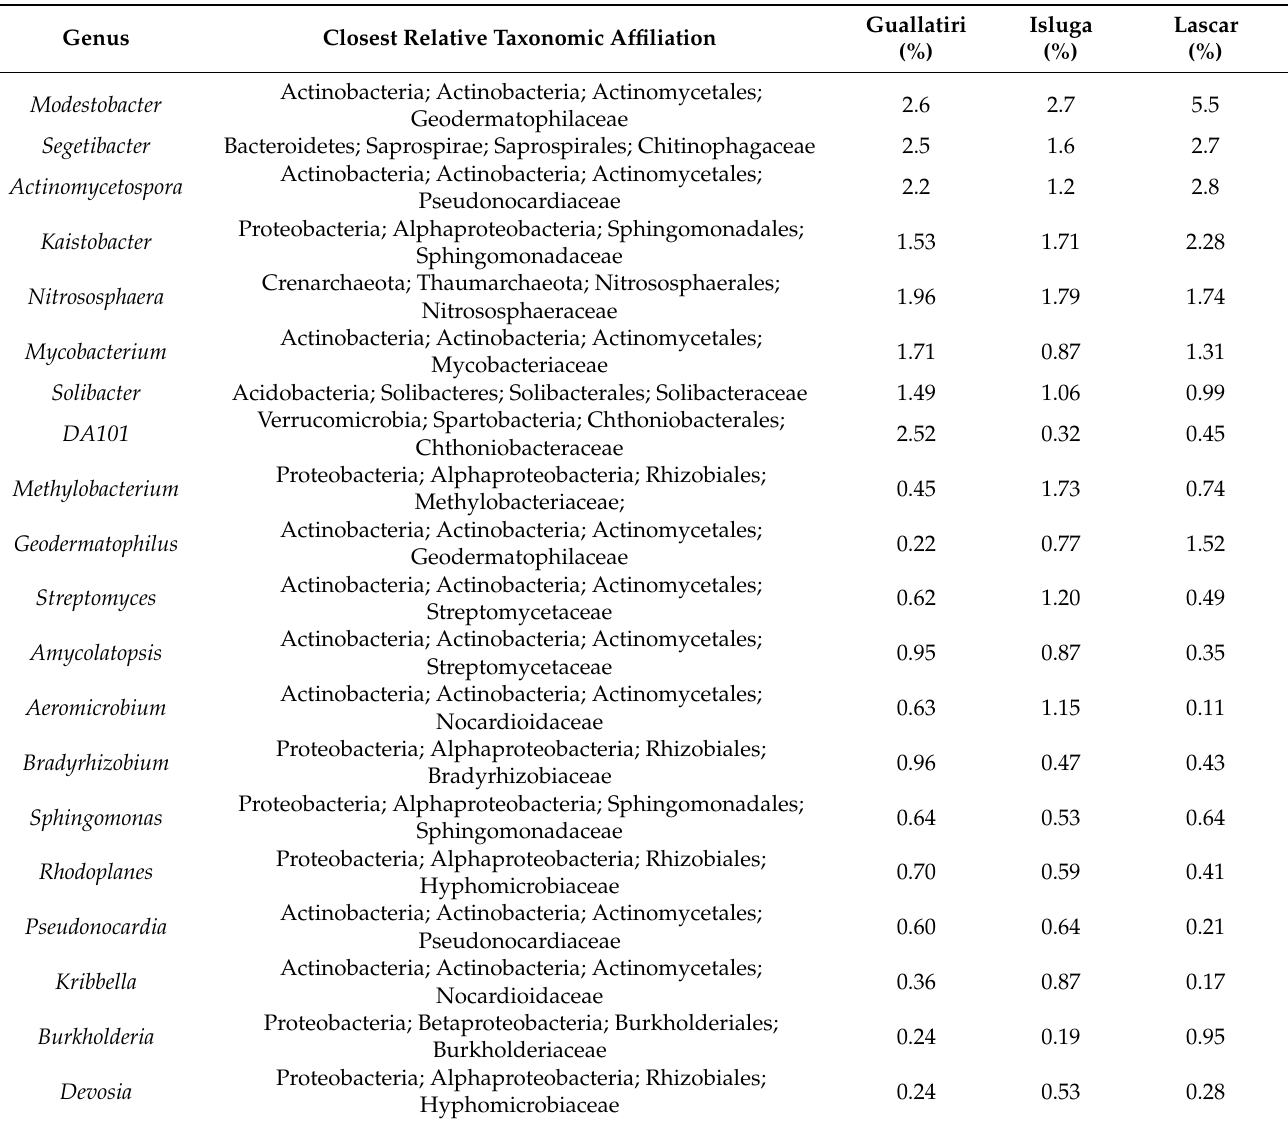
Table 2. Relative abundance (%) and taxonomic affiliation of the 20 most shared operational taxo- nomic units (OTUs) across rhizobacterial communities associated of P. quadrangularis collected from Guallatiri, Isluga, and Lascar